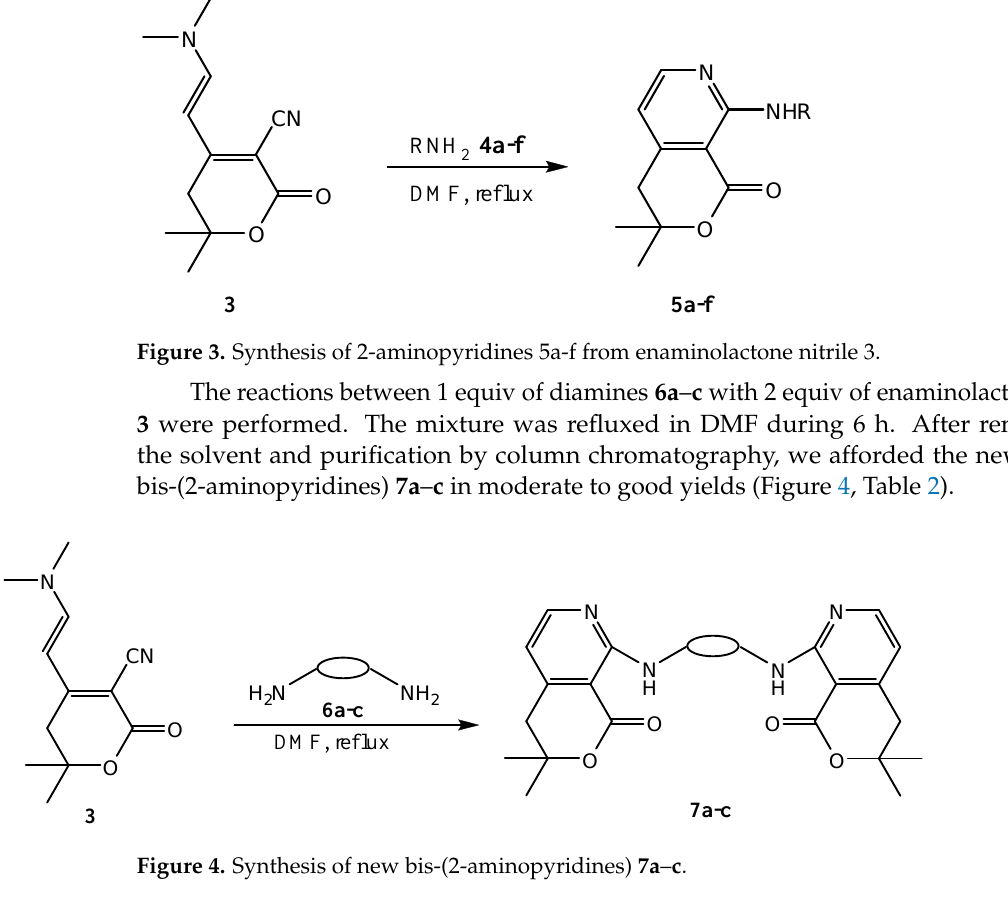
Figure 4. Synthesis of new bis-(2-aminopyridines) 7a – c. The structure of the compounds 7a – c was confirmed by spectral data (IR, 1 H NMR and 13 Table 2. Synthesis of bis-2-aminopyridine lactones.